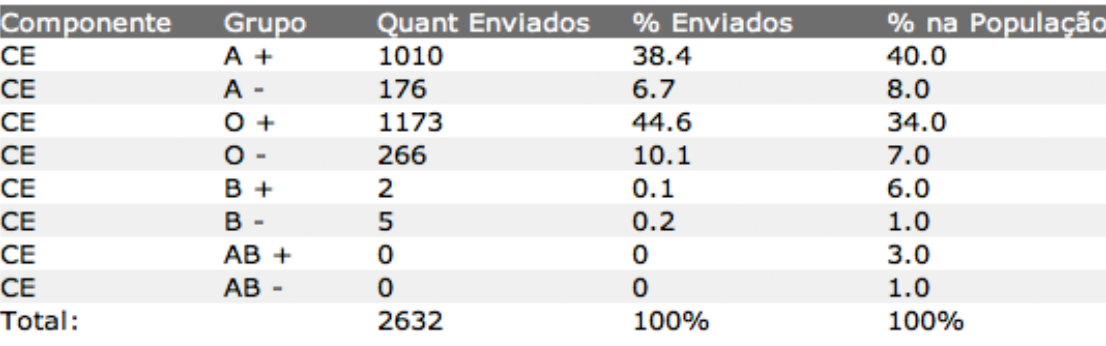
Figure 6: Red Cell Concentrates issued to a Hospital in 2011 by blood group. The number of issued units is in column 3, the percentage of issued units is in column 4 and the percentage in the Portuguese population is in column